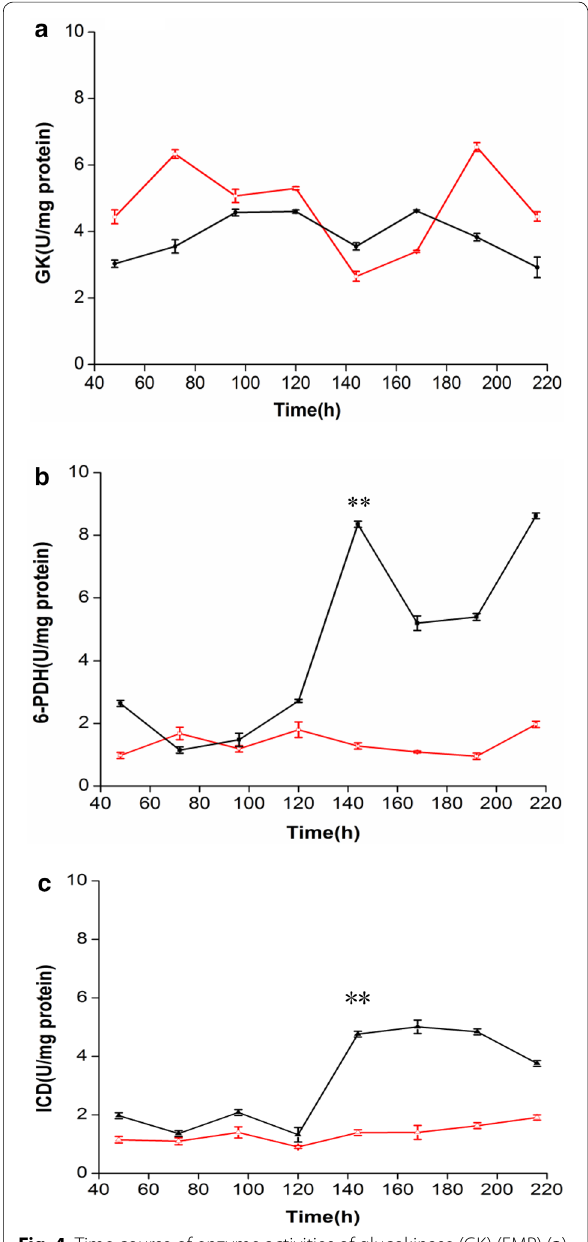
Fig. 4 Time course of enzyme activities of glucokinase (GK) (EMP) ( a ), glucose 6-phosphate dehydrogenase (G6PD) (PPP) ( b ) and isocitrate dehydrogenase (ICD) (TCA cycle) ( c ). Black: mode 8. Red: control. Each point represents the mean ( n 3) standard deviation. **Represents = ± p <